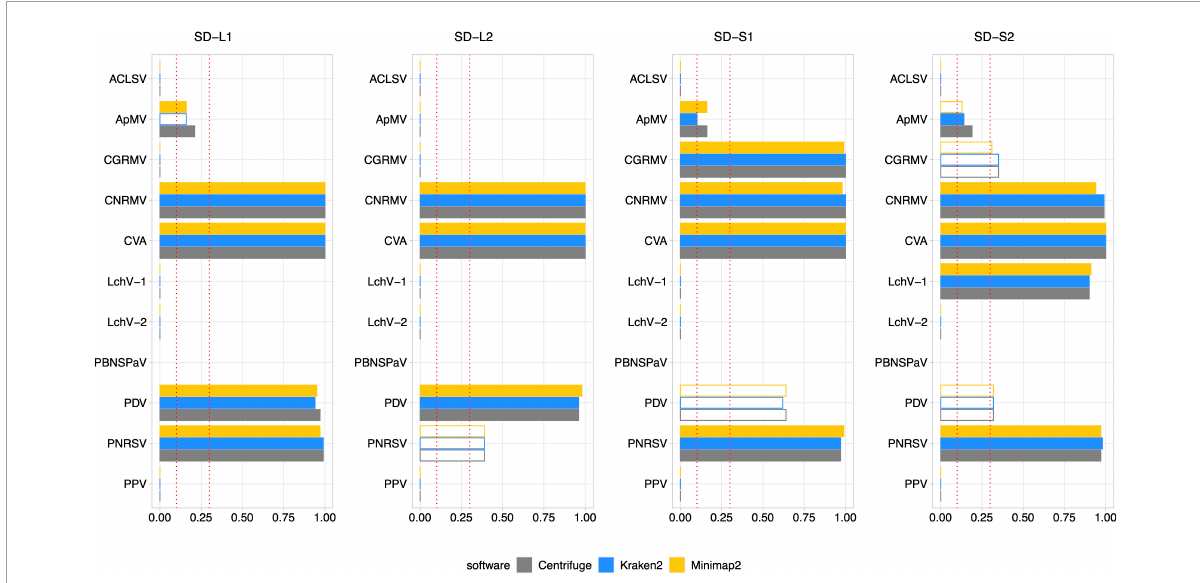
FIGURE7 Diagnosis on field samples from the shoot development stage using Pavium panel-II. HTS data from field samples (SD-L1, SD-L2, SD-S1, and SD-S2) were submitted to the pipeline using the Pavium panel-II. X-axis: VGAC scale (0–1); ordinate: abbreviated name of viruses; dotted lines: VGAC cutoffs at 0.1 and 0.3; filled bars: replicase identified. Supplementary Figure 7 depicts these data together with read assignment levels. SD, shoot development stage; VGAC, viral genome assembly coverage; ACLSV, apple chlorotic leaf spot virus; ApMV, apple mosaic virus; CGRMV, cherry green ring mottle virus; CNRMV, cherry necrotic rusty mottle virus; CVA, cherry virus A; LChV-1, little cherry virus 1; LChV-2, little cherry virus 2; PBNSPaV, plum bark necrosis stem pitting associated virus; PDV, prune dwarf virus; PNRSV, prunus necrotic ringspot virus; PPV, plum pox virus.